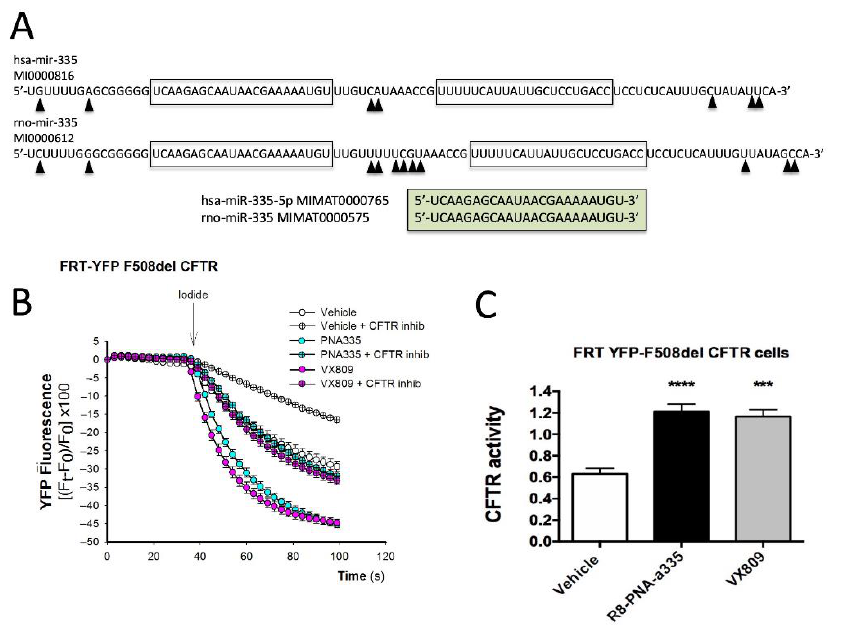
Figure 5. Effects of R8-PNA-a335 on CFTR function. ( A ) Both miR-335-5p and miR-335-3p (boxed sequences) are conserved when human (hsa) and rat (rno) pre-miR-335 sequences are compared. Arrowheads indicate mutated nucleotides. The fully homologous mature hsa and rno miR-335 sequences are shown in the light green box. B, C. Effects of R8-PNA-a335 on CFTR halide ion transport in FRT-YFP F508del CFTR cells. Cells were cultured untreated, or were treated with R8-PNA-a335 (4 μM) or VX 809 (5 μM) for 48 h. CFTR function was assessed by single-cell fluorescence imaging in the presence of the protein kinase A activator forskolin (20 µM) and genistein (50 µM). Representative traces are shown in panel ( B ). The summary of three independent experiments is shown in panel ( C ). Results are presented as transformed data to obtain the signal variation (Fx) relative to the time of addition of iodide, according to the equation: Fx ([Ft Fo]/Fo) 100, where Ft and Fo are the fluorescence values at the time t and at the time of addition of the iodide, respectively. Statistical comparisons were made using a nonparametric ANOVA test (*** p < 0.001, and **** p < 0.0001).